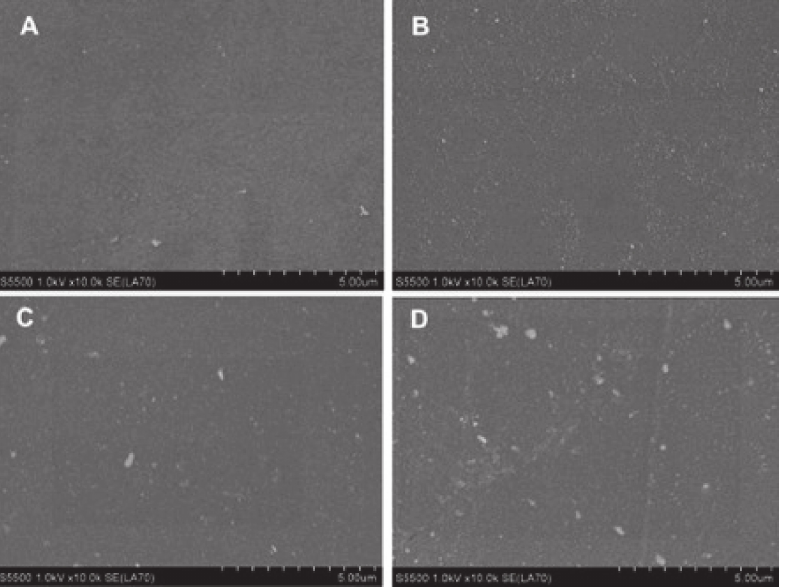
Figure 5. SEM images of PLA: ( A ) untreated PLA-T; ( B ) plasma-treated PLA-T; ( C ) untreated PLA- MC; ( D ) plasma-treated